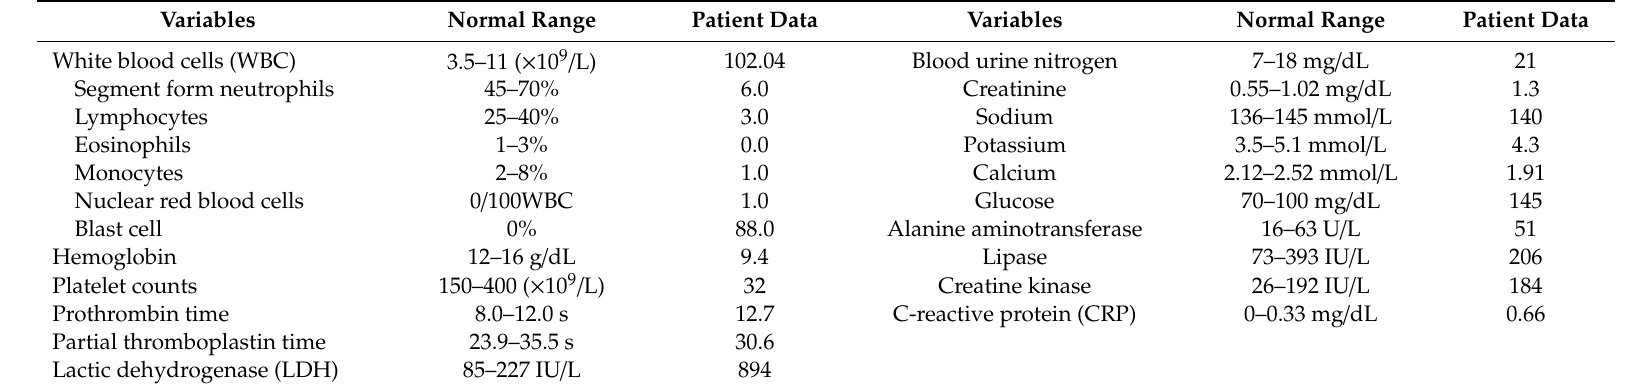
Table 1. Laboratory evaluation of the patient.